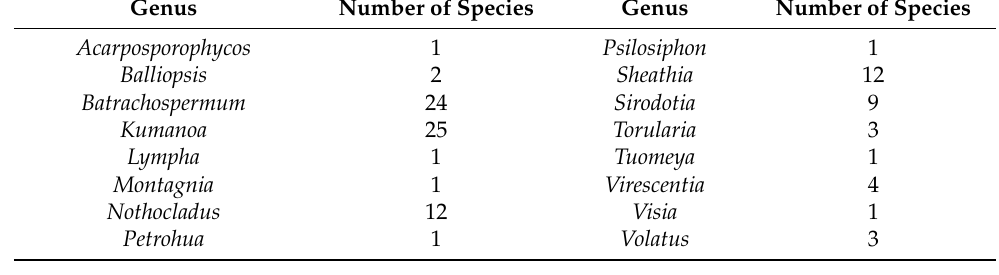
Table 1. The number of genera and species in the database compiled in this study.